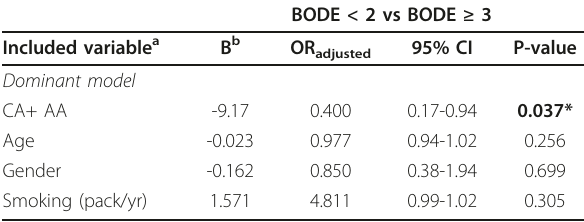
Table 3 Association tests of TNFA -863 C/A polymorphism with COPD using multiple logistic regression analysis